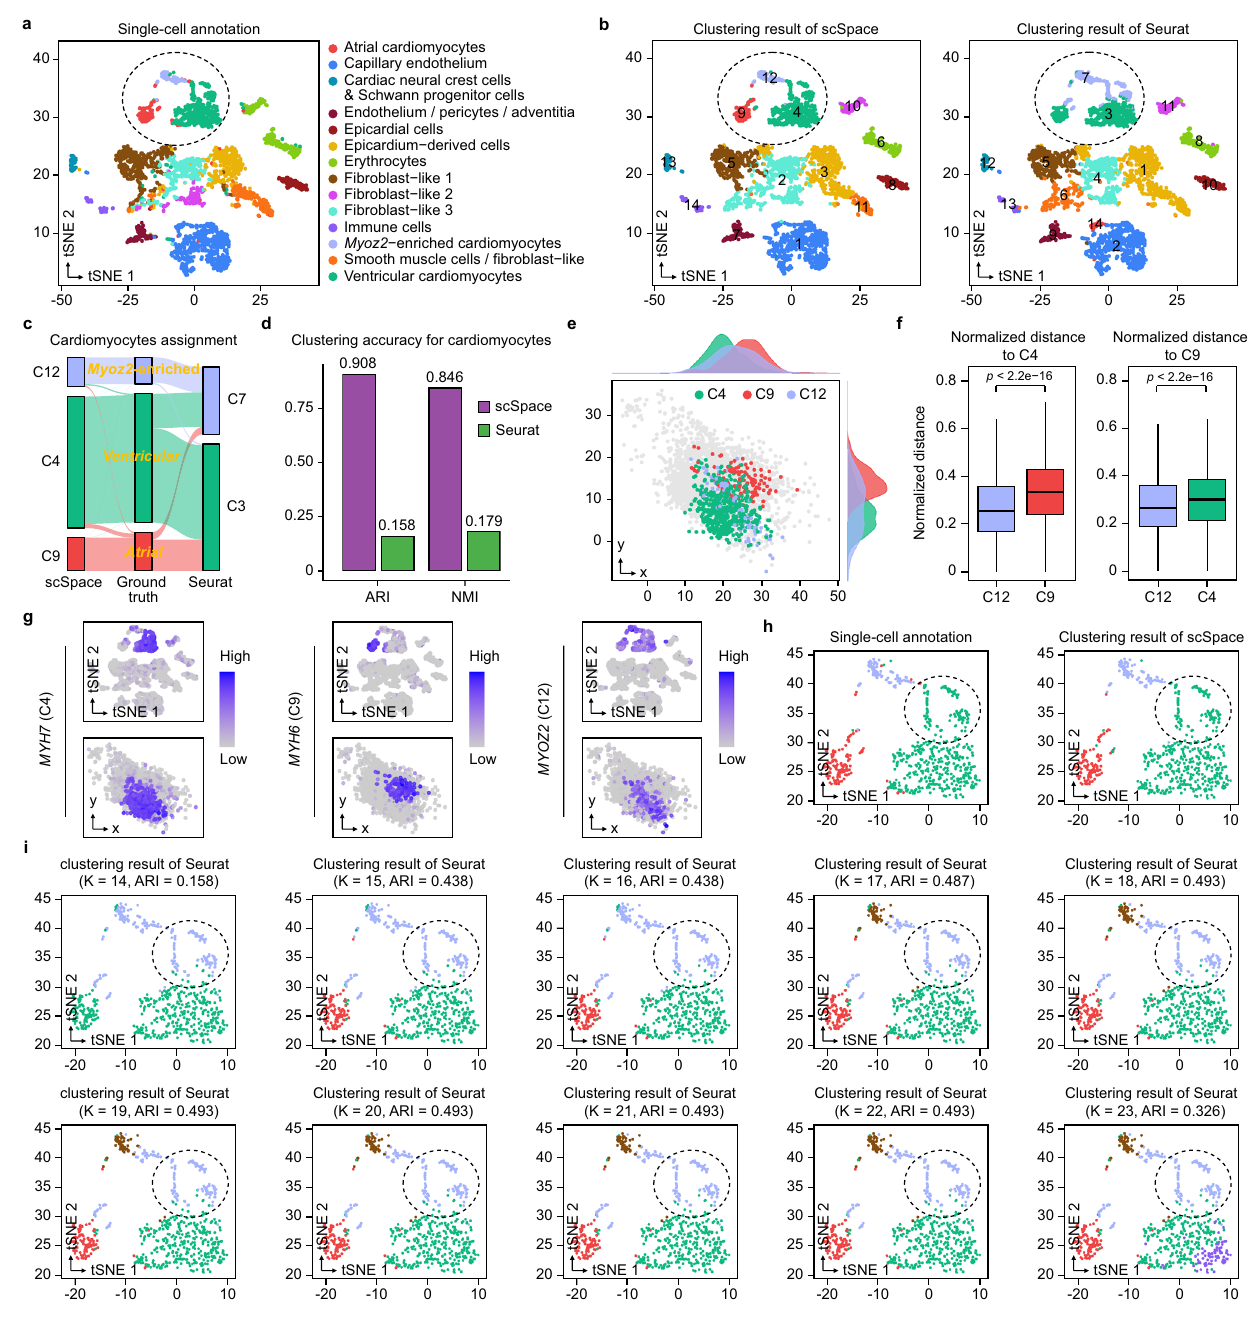
Fig. 3 | Regional reconstruction of scRNA-seq data in the human embryonic heart using scSpace. a t-SNE visualization of human embryonic heart scRNA-seq data, the single-cell annotation is obtained from the original publication. b Clustering results of scSpace (left) and Seurat (right). c Sankey plot showing the assignment of cardiomyocytes in scSpace and Seurat. d Comparison of scSpace withSeuratinidentifyingcardiomyocytesubpopulations. e Thespatialdistribution of three cardiomyocyte subpopulations (C4, C9, and C12) identi fi ed by scSpace in the pseudo-space. f Normalized pairwise distance between different cardiomyo- cyte subpopulations to C4 (left) and C9 (right). Data are presented as boxplots (minima, 25th percentile, median, 75th percentile, and maxima). The number of